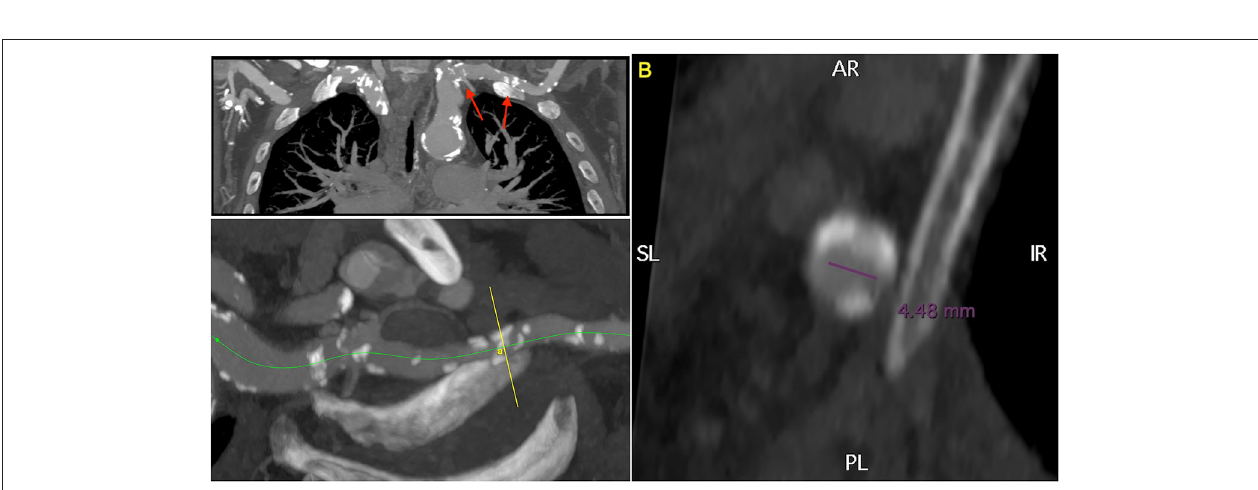
FIGURE 4 | 3D multiplanar reconstruction of the left subclavian artery, demonstrating moderate calcifications and a focal stenosis with a residual lumen of < 5mm. The red arrows indicate the target lesions of the